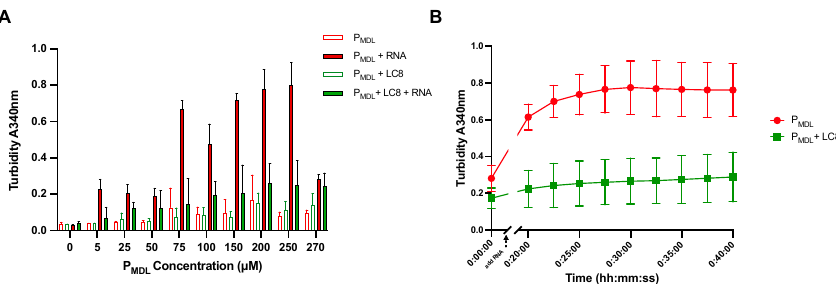
Figure 4. P MDL aggregated upon addition of RNA as a crowding agent and LC8 antagonized aggregation in vitro. ( A ) Turbidity measurements at 340 nm at increasing concentrations of P MDL , P MDL + RNA, P MDL + LC8, and P MDL + LC8 + RNA. Measurements were performed in triplicates, bars represent the mean, and error bars represent the positive standard deviation. ( B ) Kinetics of turbidity increased upon addition of RNA (time point, black arrow) in both P MDL alone and P MDL preincubated with LC8 in the time range of 40 min.